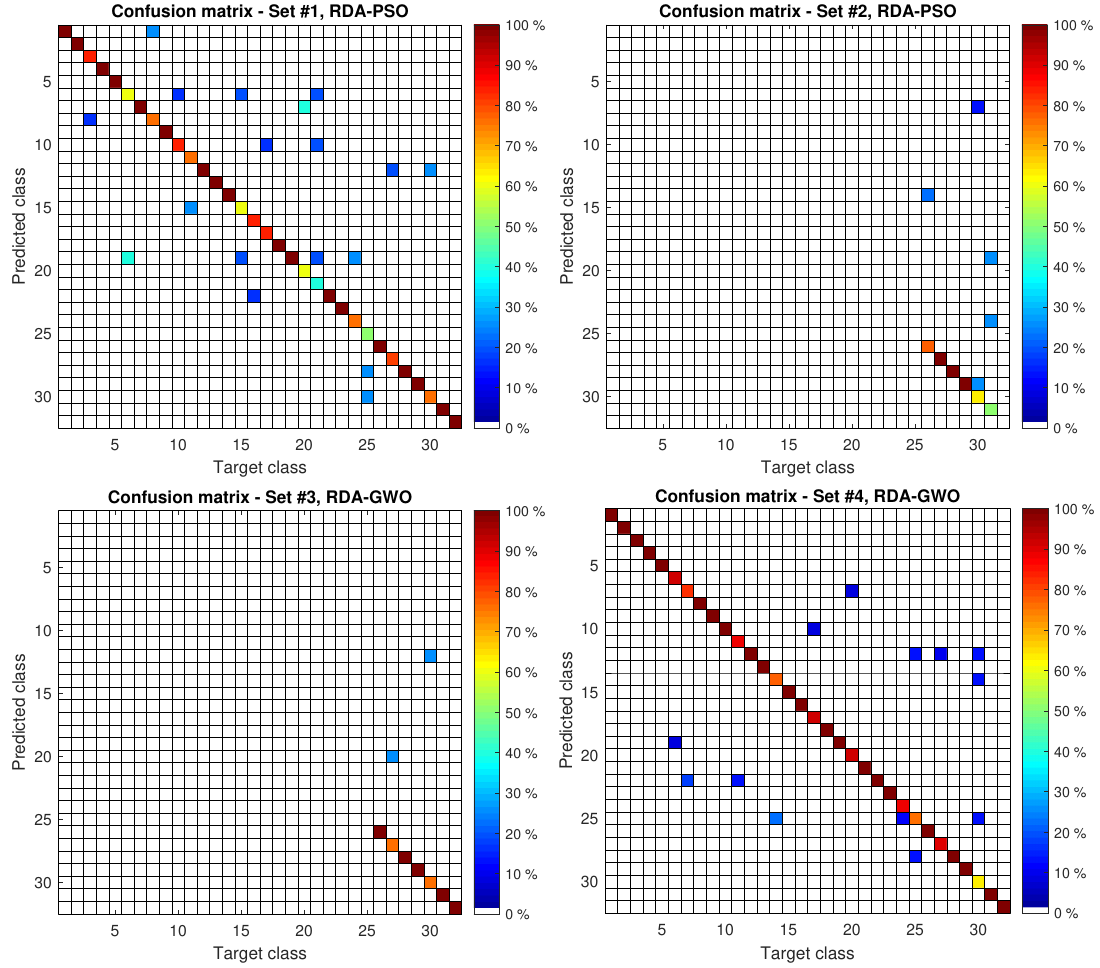
Figure 4. Confusion matrices for best models in each